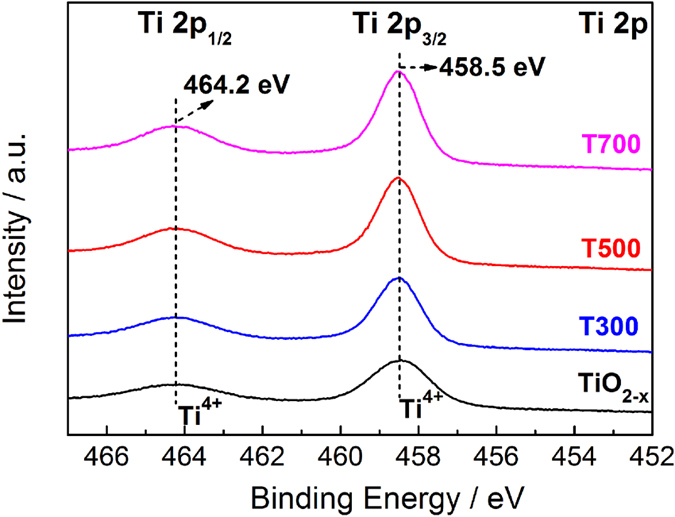
Ti 2p XPS spectra of the brookite TiO2−x, T300, T500 and T700 samples.